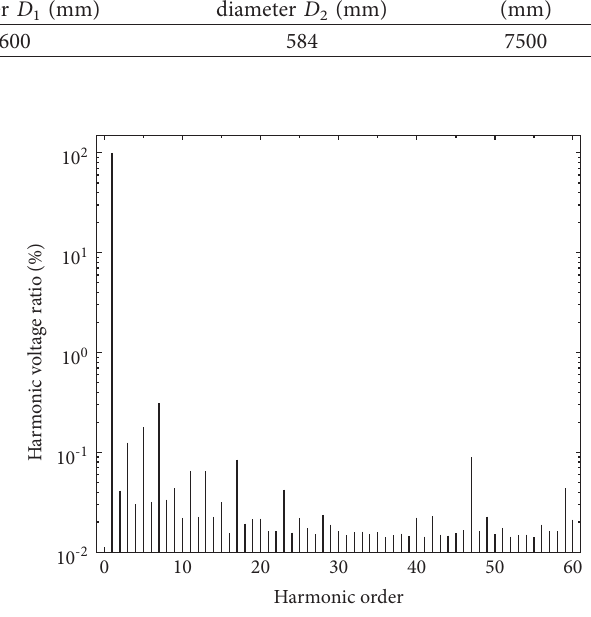
Figure 5: The first 60 harmonic